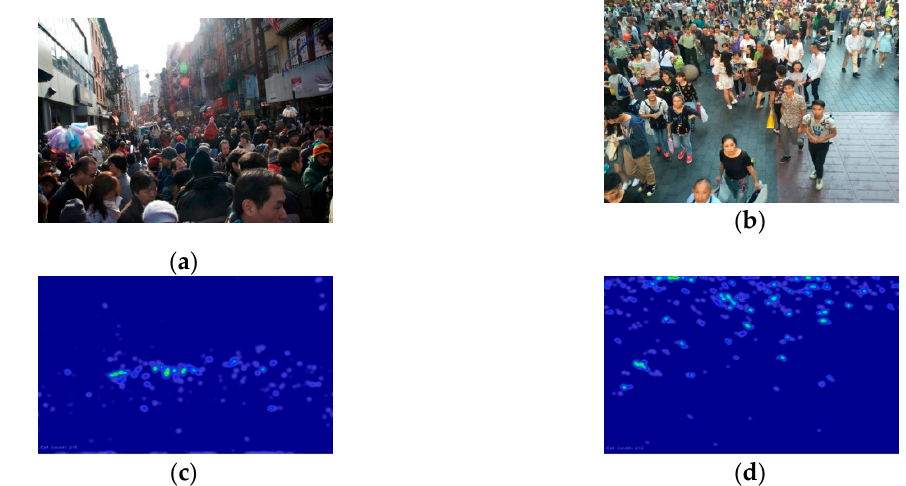
Figure 6. ( a , b ) are two sample images from ShanghaiTech Part_A and Part_B respectively. ( c , d ) are their density map generated by DSA-CNN. Table 2. The comparison on ShanghaiTech dataset.